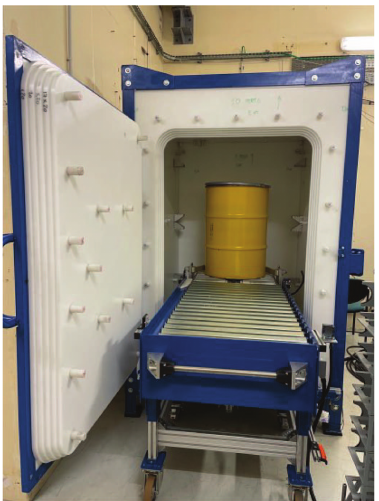
Fig. 7. Neutron detection system installed at CEA